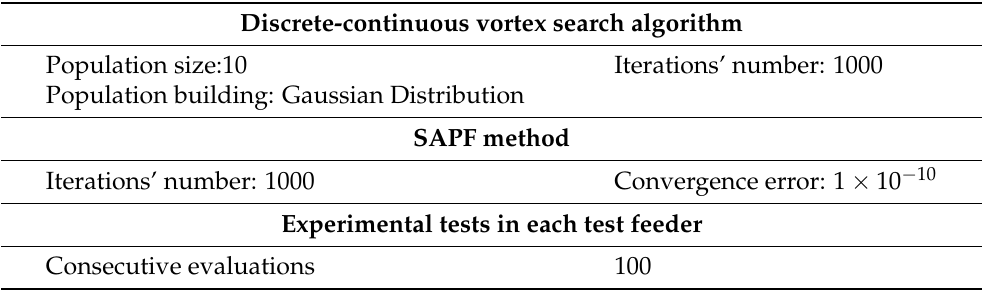
Table 6. Parametrization of the DCVSA.